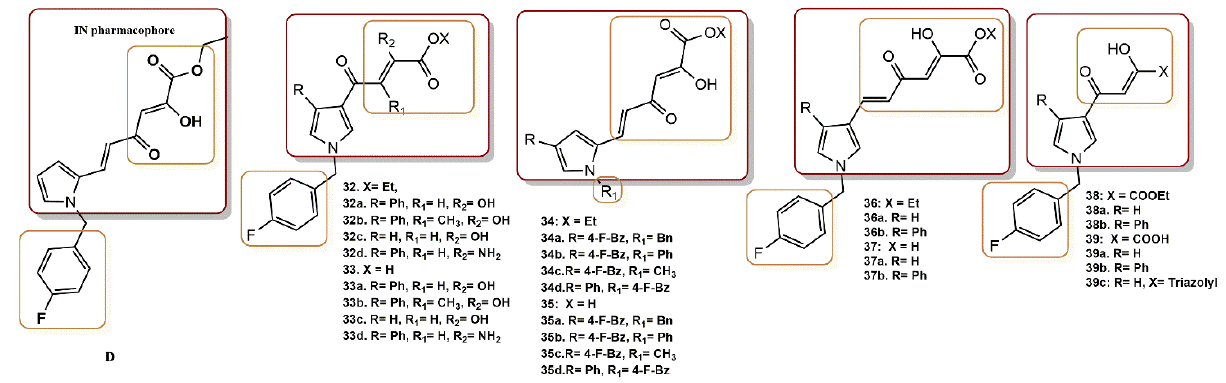
Figure 27. RT and IN pharmacophores of new active synthesized compounds 32a-d , 33a-d , 34a-d , 35a-d , 36a-b , 37a-b , 38a-b and 39a-c